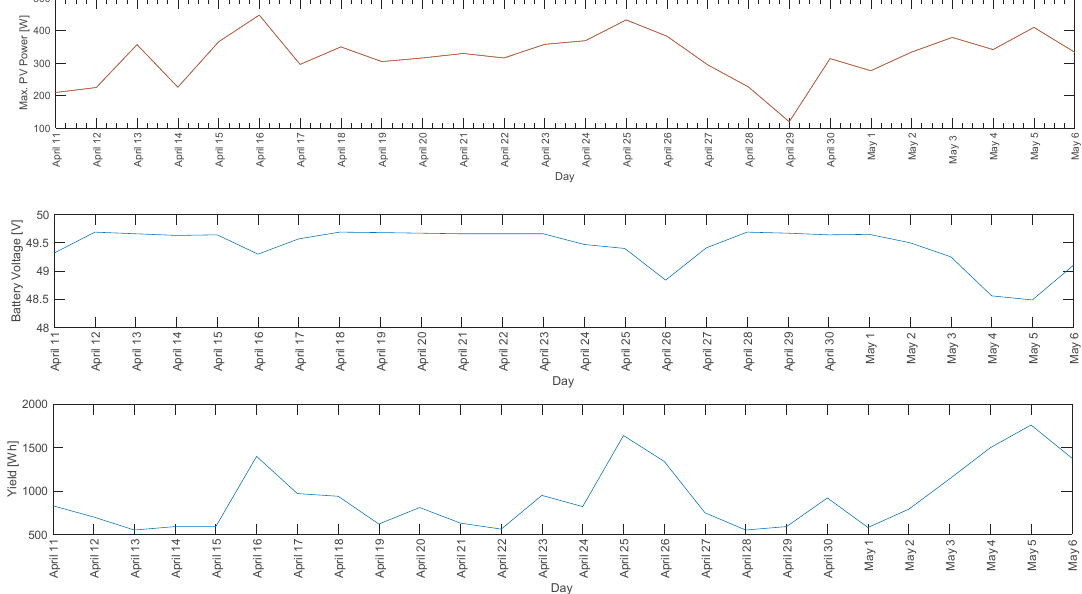
Figure 31. Maximum power generated by the PV array in the BiCiSOLAR charging station ( top ), battery voltage ( center ) and charging station consumption ( bottom ).